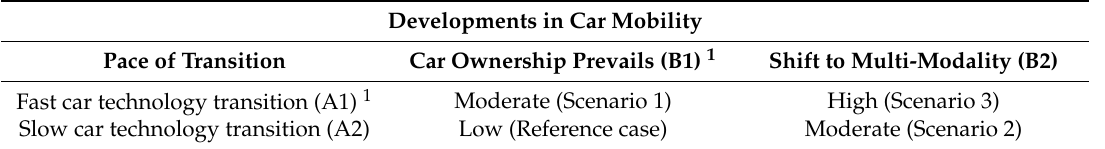
Table 3. Framework for developing